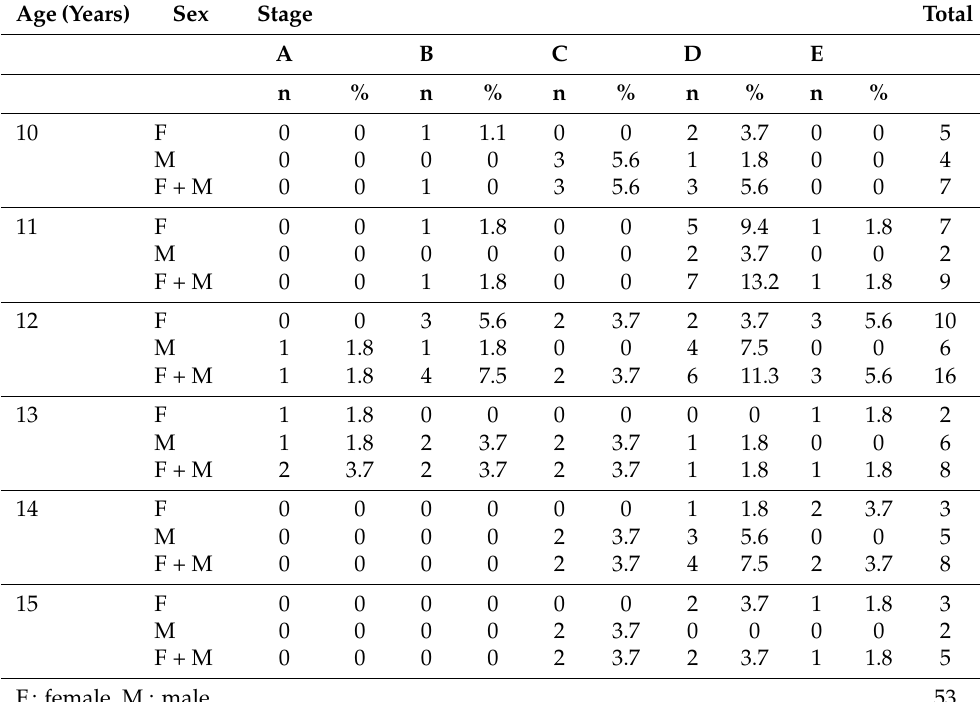
Table 2. Distribution of the MPS maturational stages by age and sex in 10- to